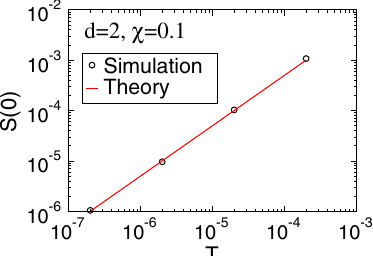
FIG. 13. Comparison of the theoretically predicted structure factor at the origin S ð 0 Þ versus absolute temperature T , as obtained from Eq. (93), to our corresponding simulation results for a two-dimensional stealthy system at χ ¼ 0 . 1 . Here, we take k v 0 ¼ K ¼ 1 B ¼